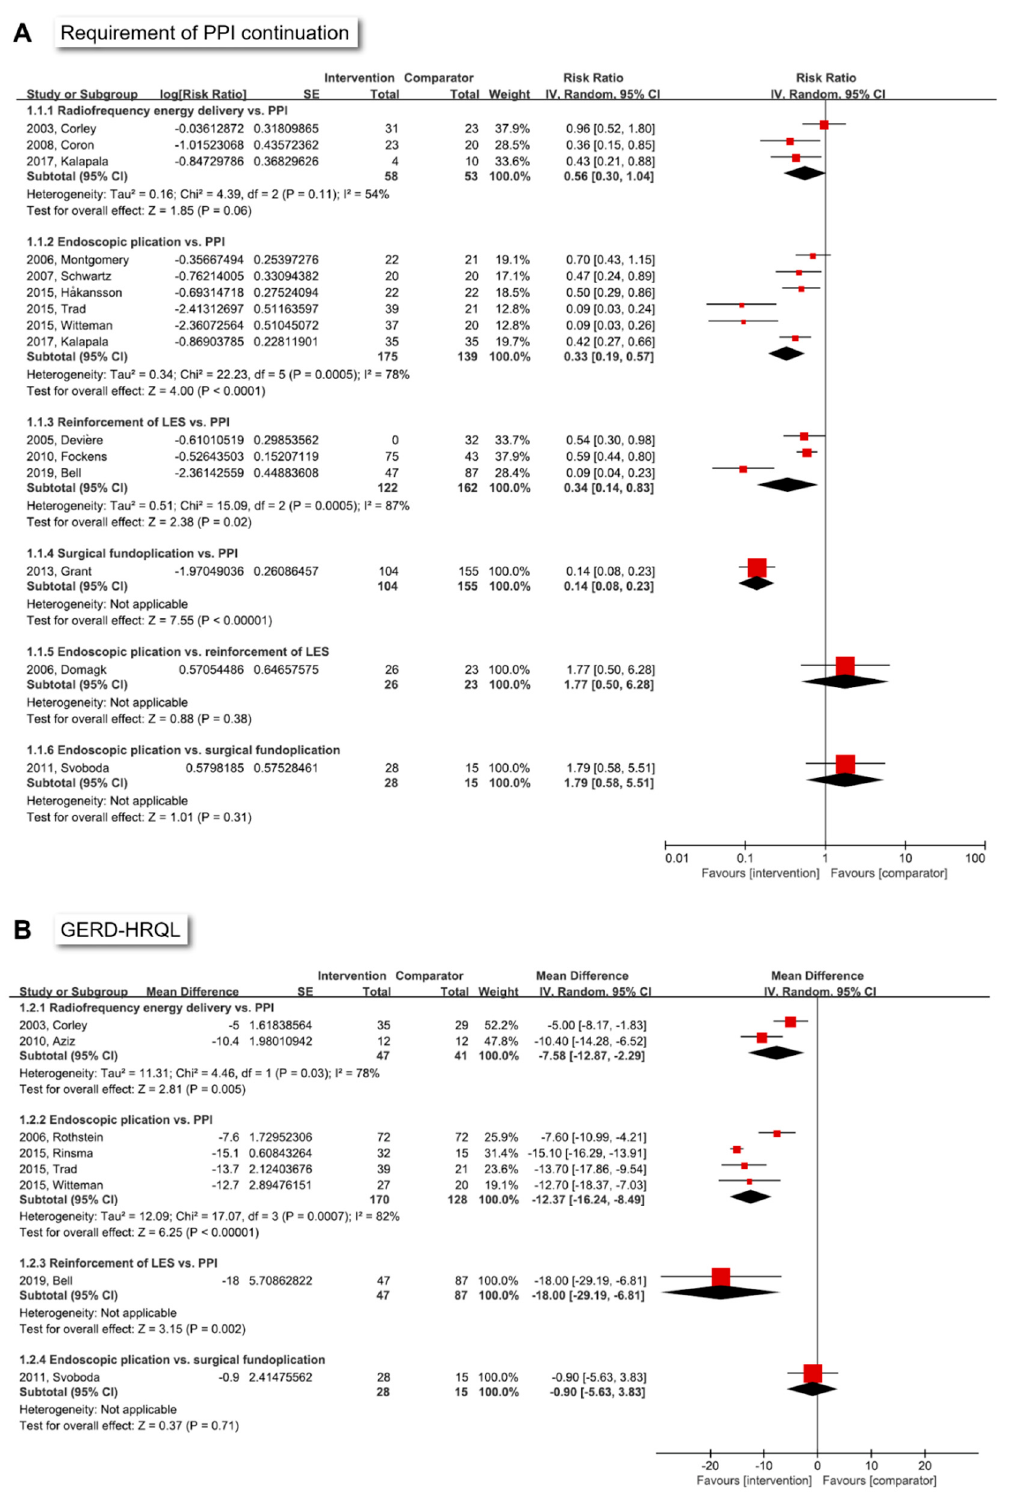
Figure 3. Direct meta-analysis of the requirement of PPI continuation ( A ) and GERD-HRQL ( B ) of endoscopic or surgical treatments. PPI, proton pump inhibitor; GERD, gastroesophageal reflux disease; HRQL, health-related quality of life questionnaire; LES, lower esophageal sphincter; SE, standard error; IV, inverse variance; CI, confidence interval; df, degrees of freedom. Direct meta-analysis results of the GERD-HRQL score, which indicate that the lower the value, the better the quality of life, are shown in Figure 3B. Both radiofrequency energy